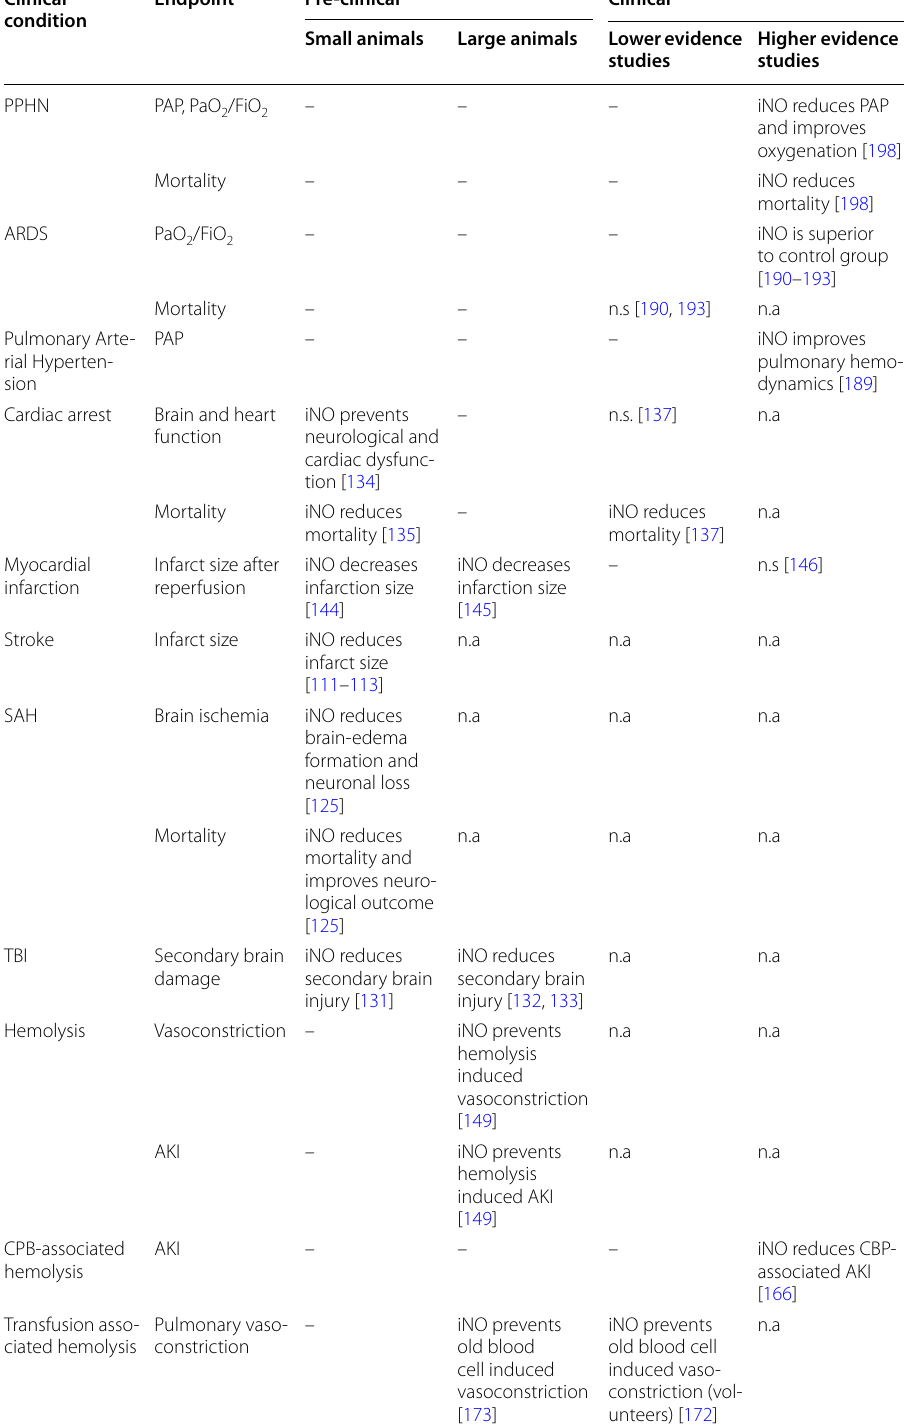
Table 1 Highest level of evidence so far available about the iNO potential for clinical applications and highlights on research gaps before trialing specific area of